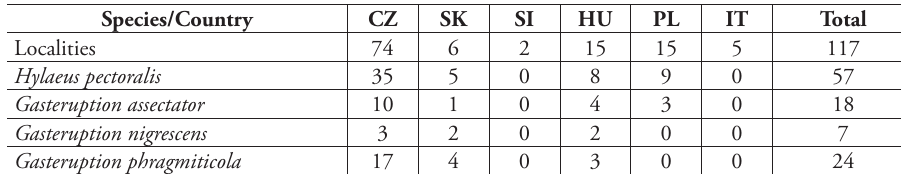
Table 1. Numbers of localities of Hylaeus pectoralis , Gasteruption assectator , Gasteruption nigrescens and Gasteruption phragmiticola in countries of the present study. CZ – Czech Republic, SK – Slovakia, SI – Slovenia, HU – Hungary, IT – Italy, PL – Poland.